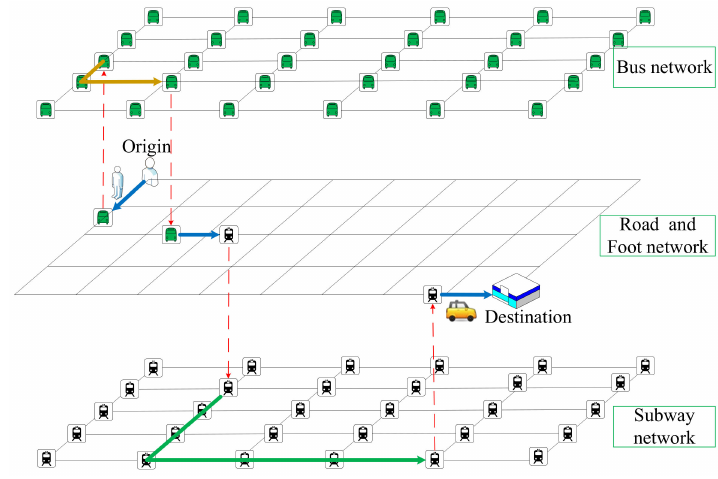
Figure 1. A hierarchical multimodal network